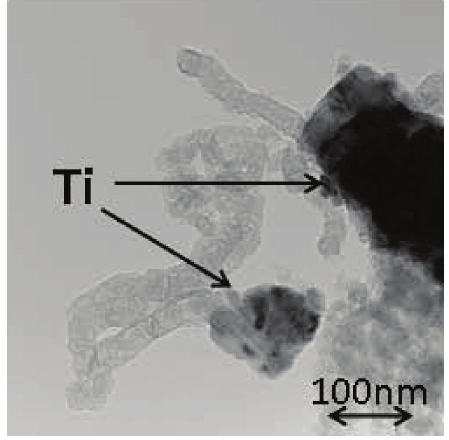
Figure 6. TEM image of the carbonaceous compounds with titanium particles. The pyrolysis temperature is 1023